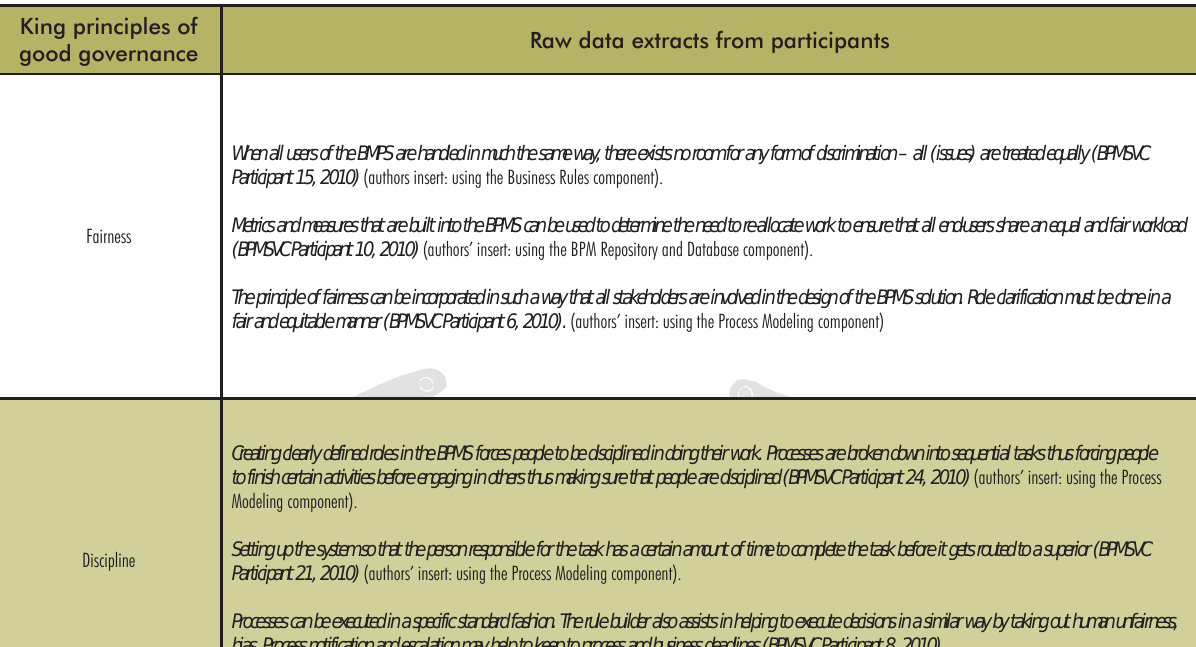
TABLE 2: IDEAS FOR INSCRIBING THE GOOD GOVERNANCE PRINCIPLES INTO THE ARCHITECTURAL COMPONENTS OF A BPMS King principles of Raw data extracts from good governance